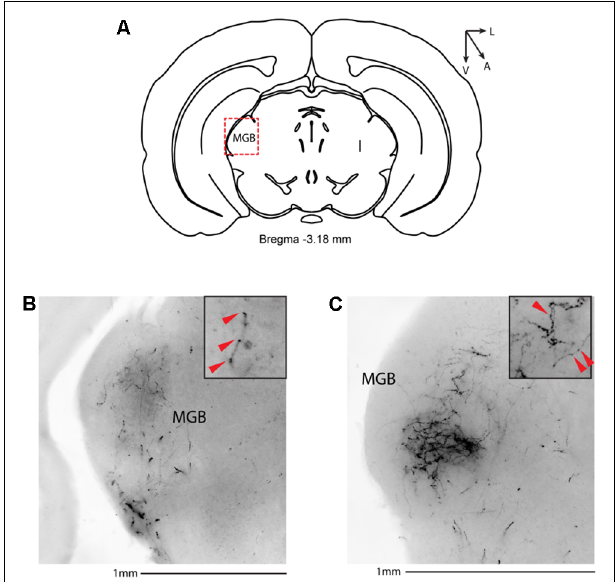
FIGURE 6 | Subcortical target of long-range VIP-expressing neurons: thalamus. (A) Allen Brain reference coronal section at − 3.18 mm from Bregma. The Red dashed square indicates the region imaged in the panels below. (B,C) Two examples of the medial geniculate body from two different animals. Scale bar: 1 mm. Insets indicate axonal branches and the red arrowheads boutons. Inset size 190 µ m. MGB, medial geniculate